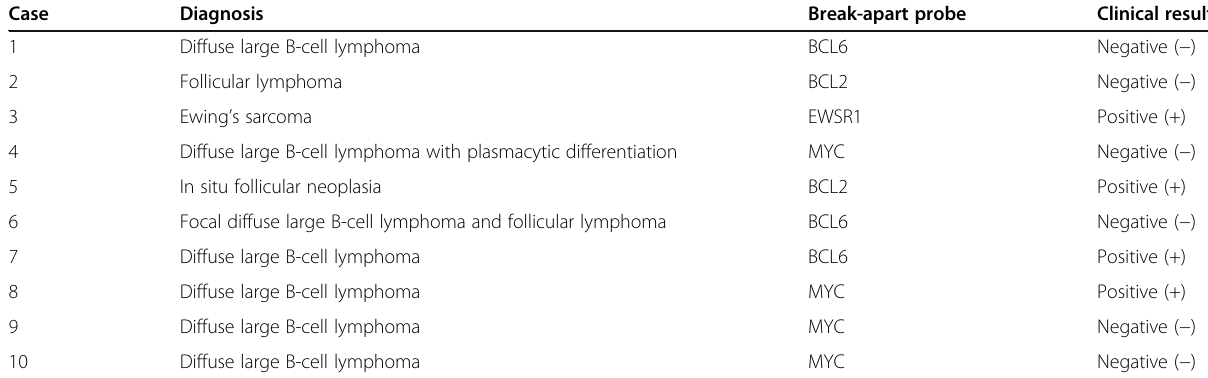
Table 1 Dataset for FISH diagnosis of lymphoma and solid tumors patients Case